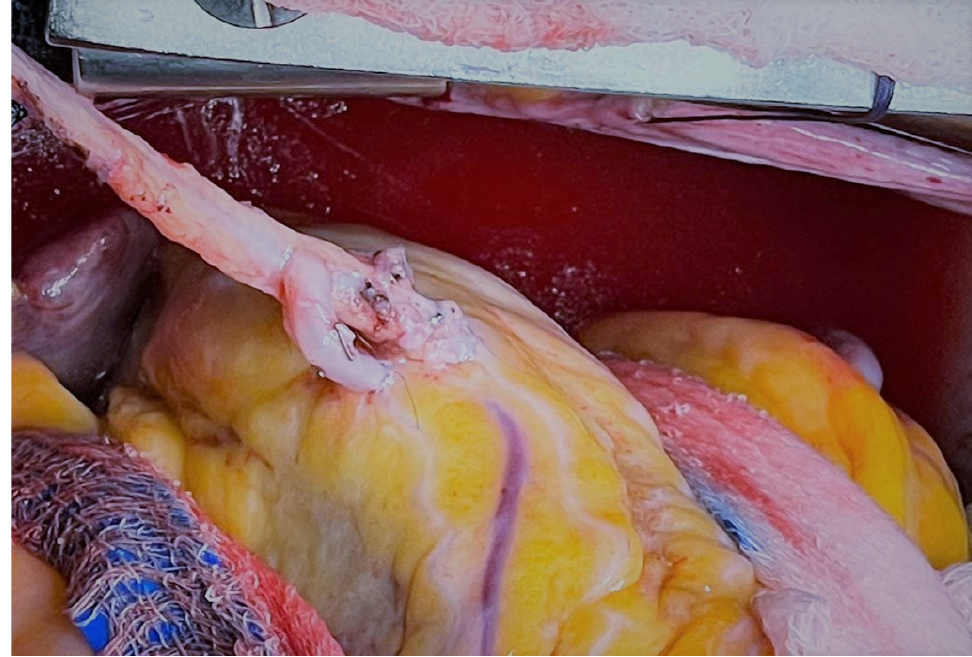
Figure 3. Baby ‐ Y graft of radial artery and saphenous vein to obtuse marginal branches of left circumflex artery.